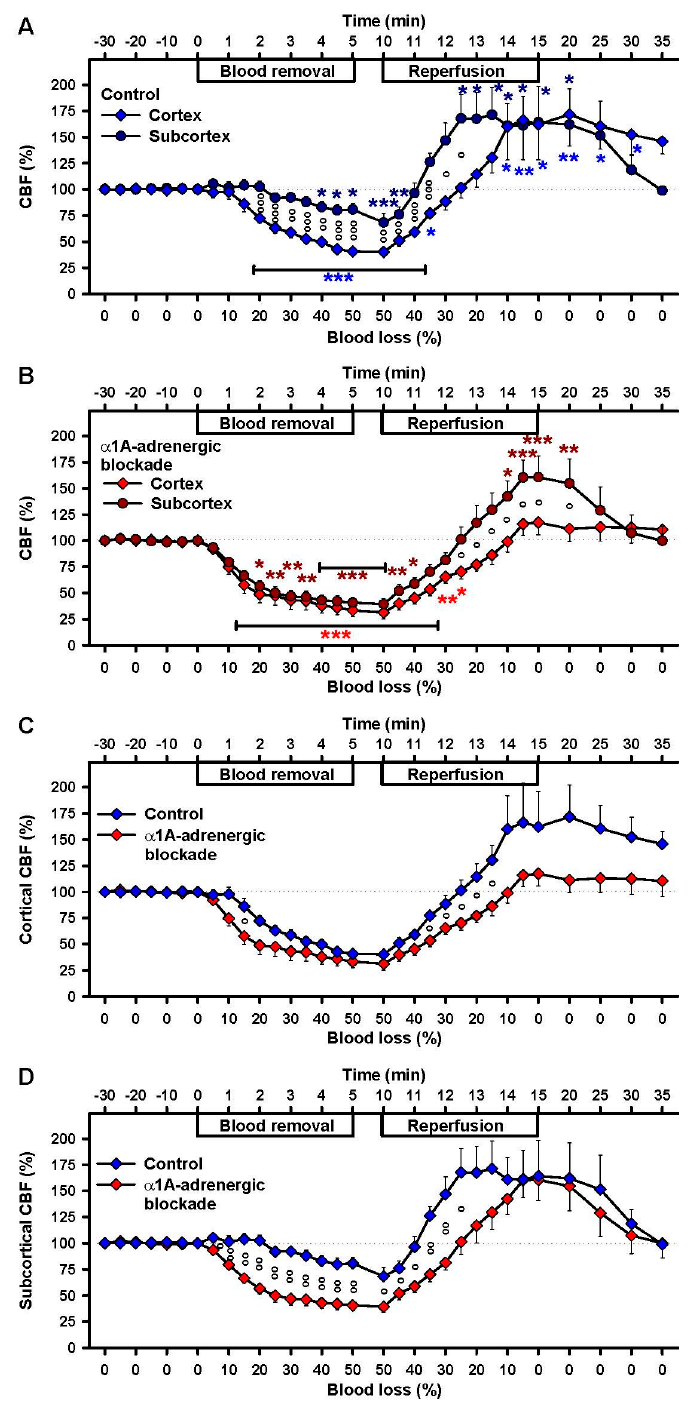
Figure 3. Effects of 50% blood loss and reperfusion on cortical and subcortical cerebral blood flow (CBF). Comparison of cortical and subcortical CBF in the control group ( A ) and under α 1A-adrenergic blockade ( B ). Comparison of controls and α 1A-adrenergic blockade for ( C ) cortex and ( D ) subcortex. Means ± SEM; * p < 0.05, ** p < 0.01 and *** p < 0.001 compared to baseline; ° p < 0.05, °° p < 0.01 and °°° p < 0.001 for comparison between two experimental groups.